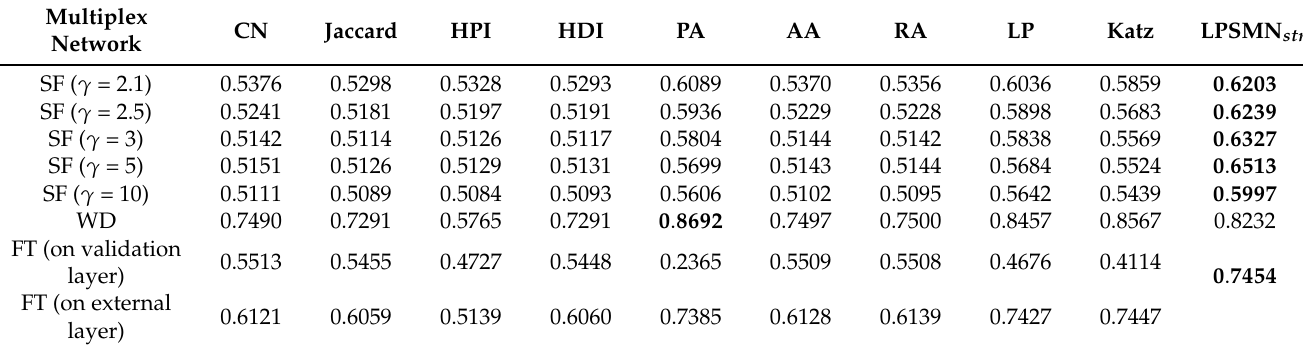
Table 2. Comparison with heuristic methods